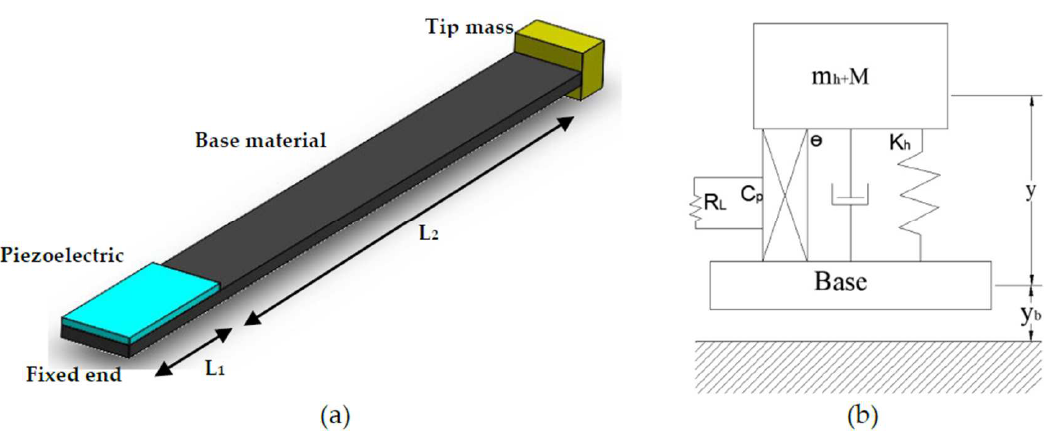
Figure 2. ( a ) The diagram of the piezoelectric harvester with tip mass; ( b ) the simplified single-degree model.